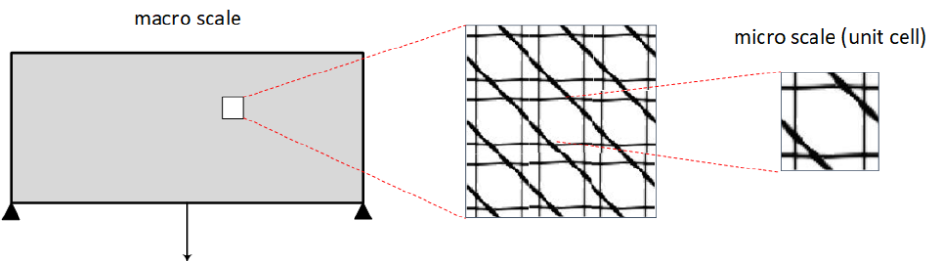
Figure 1. Schematic representation of the periodic unit cell (micro scale) inside the macro structure (macro